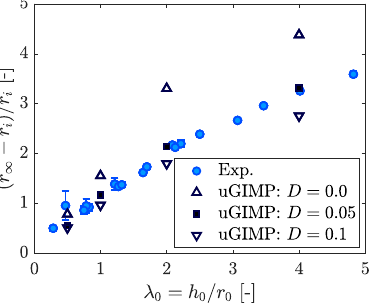
Figure 10. Direct comparison between the experimental results and the numerical solutions using ep2-3De v1.0 . The local damping D strongly influences the final normalised run-out distance. This was expected since it damps the out-of-balance forces calculated on the background mesh. For D = 0.05, the numerical solution given by ep2-3De v1.0 agrees with the experiments, even though some discrepancies exist.